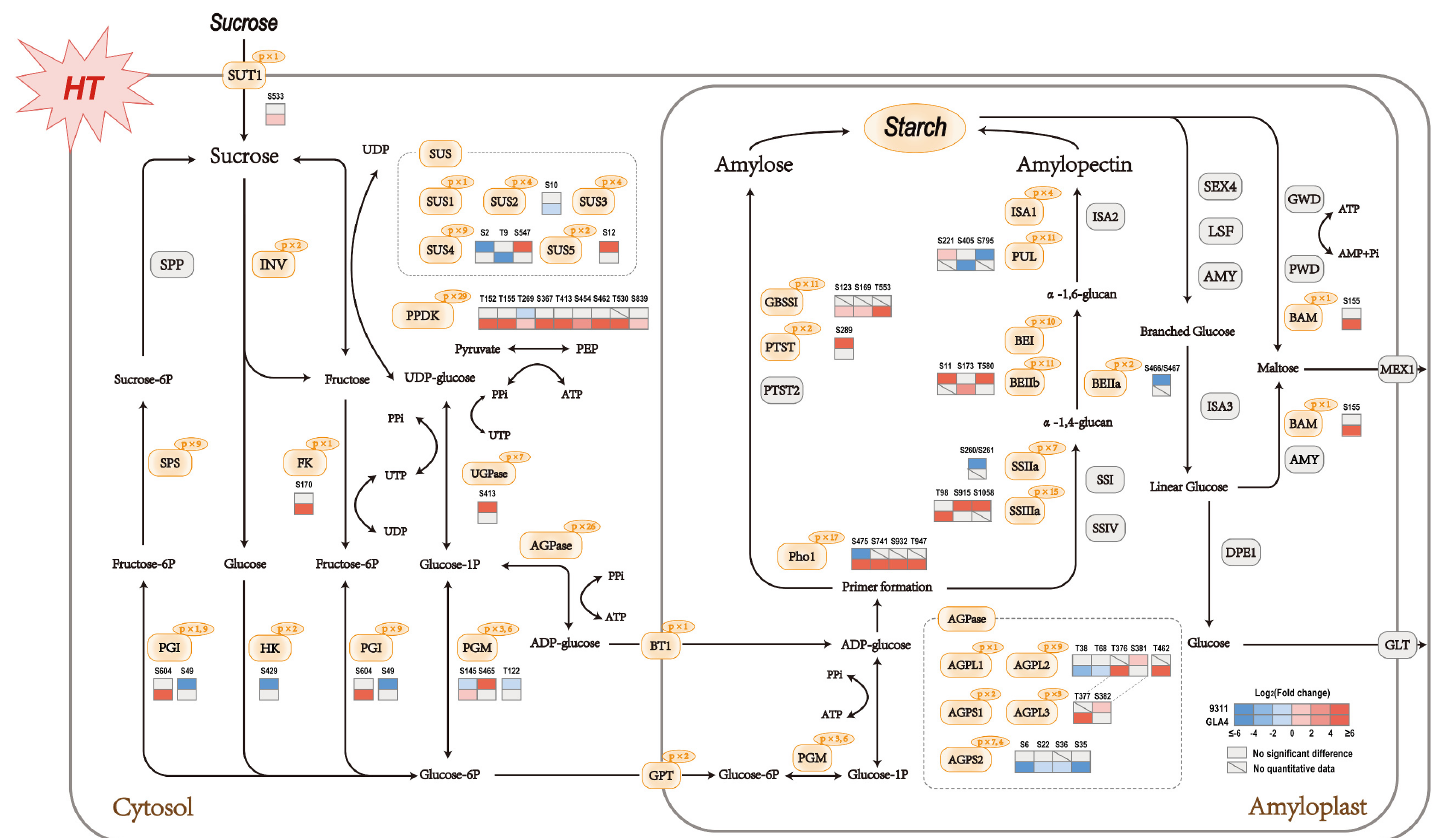
Figure 5. Sucrose and starch pathway at the phosphorylation levels in rice endosperm under high-temperature stress. Orange and gray shadings represent phosphorylated and non-phosphorylated proteins, respectively. The number of phosphosites is shown at the top right of rounded boxes. Sucrose hydrolysis: SUS, sucrose synthase; INV, invertase; SPP, sucrose-phosphate phosphatase; SPS, sucrose-phosphate synthase; FK, fructokinase; HK, hexokinase; PGI, glucose-6-phosphate isomerase; PGM, phosphoglucomutase; UGPase, UDP-glucose pyrophosphorylase. Starch synthesis: AGPase, ADP-glucose pyrophosphorylase; GBSSI, granule-bound starch synthase I; PTST, protein targeting to starch; SSI, SSIIa, SSIIIa, and SSIV, starch synthase I, IIa, IIIa, and IV, respectively; BEI, BEIIa, and BEIIb, starch branching enzyme I, IIa, and IIb, respectively; ISA1, ISA2, isoamylase isoform 1 and 2, respectively; PUL, pullulanase; Pho1, plastidial phosphorylase. Starch hydrolysis: AMY, α -amylase; BAM, β -amylase; LSF, like sex four; SEX4, starch excess 4; ISA3, isoamylase isoform 3; GWD, glucan water dikinase; PWD, phosphoglucan water dikinase; DPE1, disproportionating enzyme 1. Protein transport: SUT1, sucrose transporter; BT1, small-solute transporter; GPT, phosphometabolite transporter; MEX1, maltose transporter; GLT, glucose